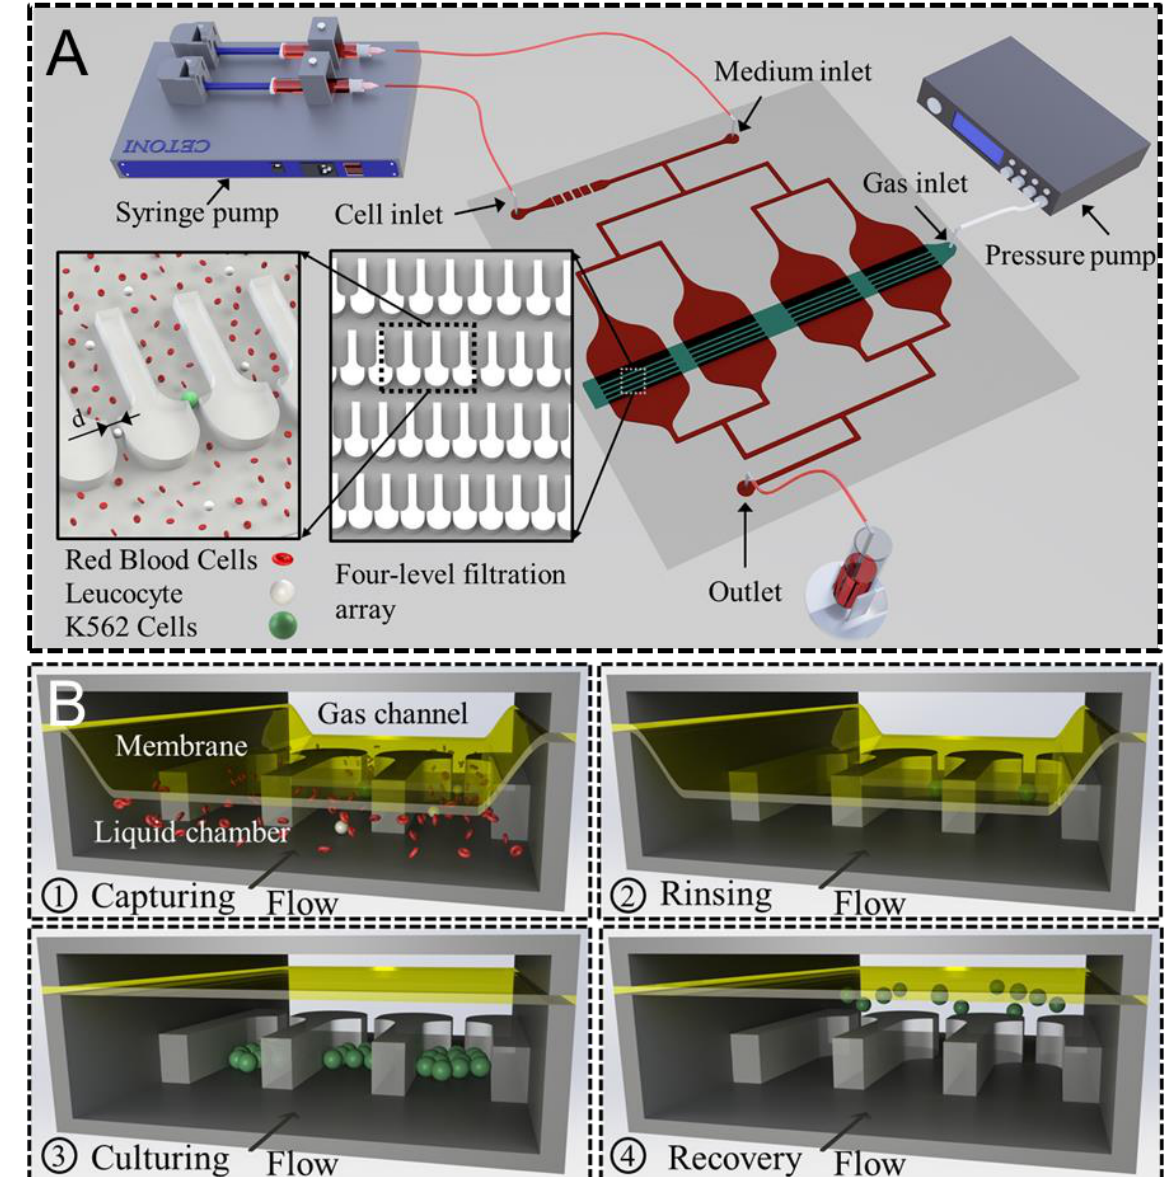
Figure 1. Schematic drawing of the microfluidic system for screening and clonal expansion of circulating tumor cells. ( A ) The whole system including a microfluidic chip containing four-level filtration arrays (inset) with sizes of 17 µ m, 13 µ m, 10 µ m, and 7 µ m. ( B ) The membrane of the pneumatic valve was employed to either increase or decrease the fluid shear stress through the filtration channels during capturing/rinsing and culturing/recovery, respectively.